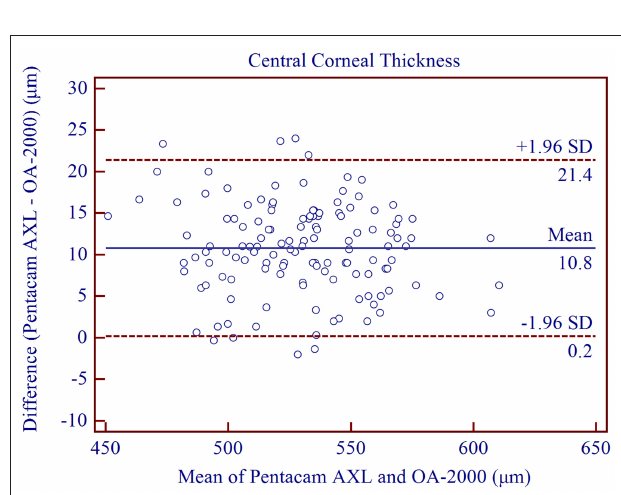
FIGURE 2 | Bland-Altman plots showing agreement between the new Scheimpflug imager in combination with partial coherence interferometry biometer and the swept-source optical coherence tomography-based biometer for measuring central corneal thickness. Solid lines represent the bias between the two devices and dotted lines represent the 95% confidence interval for the